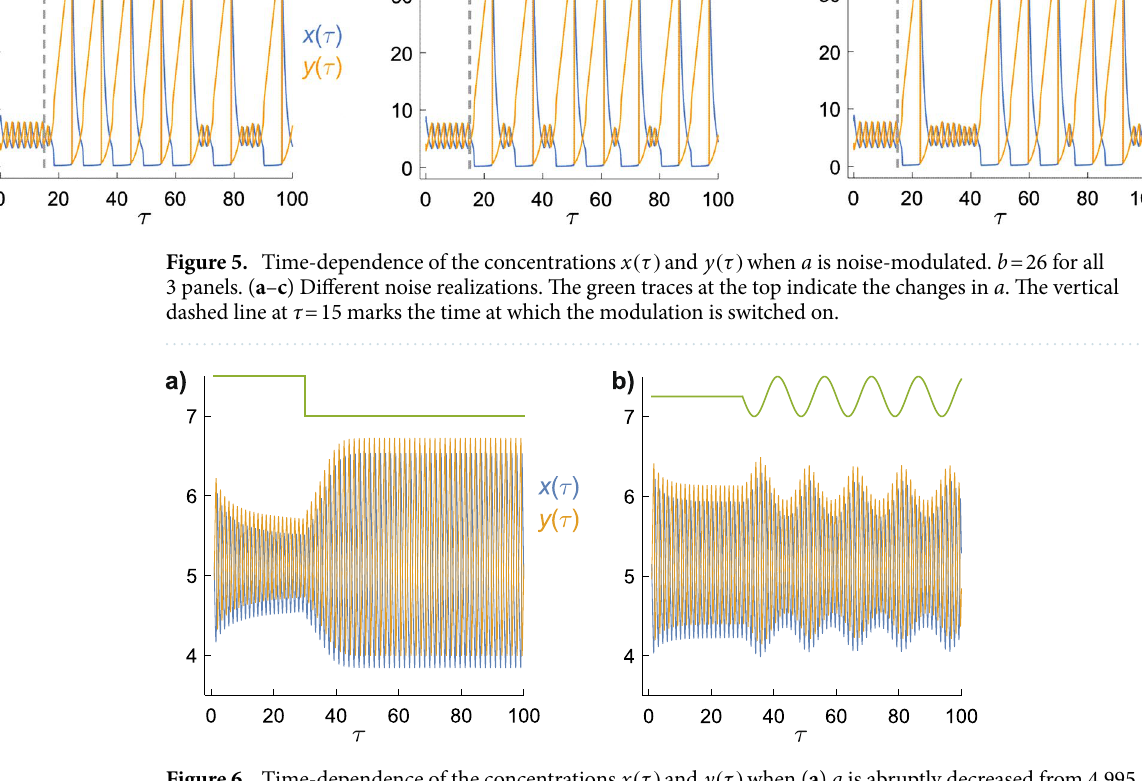
Figure 6. Time-dependence of the concentrations x (τ) and y (τ) when ( a ) a is abruptly decreased from 4.995 to 4.975, and ( b ) when a is sinusoidally modulated: a = 4.985 → a = 4.985 − 0.01 sin ( 2 πτ/ 15 ) . b = 26 for both panels. The green lines at the top indicate the changes in